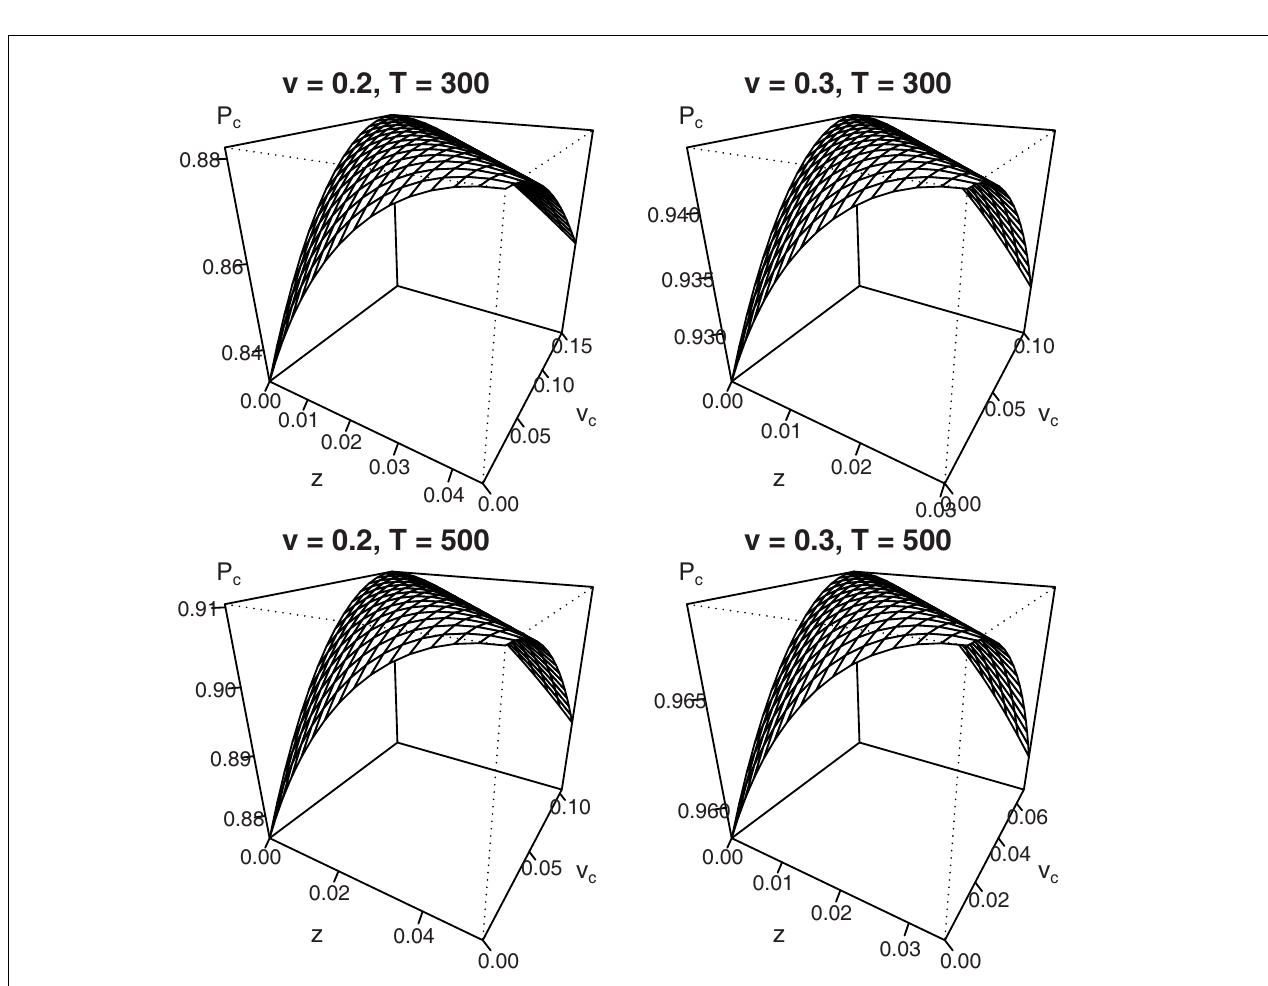
FIGURE 5 | Mean percentage correct for variable difficulty ( η = 0.1) in the interrogation paradigm for different combinations of starting point z and shift in mean drift rate v c . Due to the trade-off (cid:5) z = (cid:5) v c · T , no unique maximum exists.